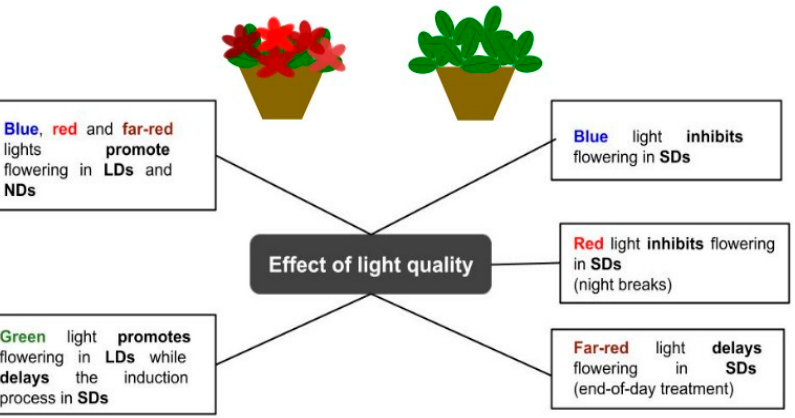
Figure 2. Schematic representation of the effect of light quality on the flowering process of ornamental plants.